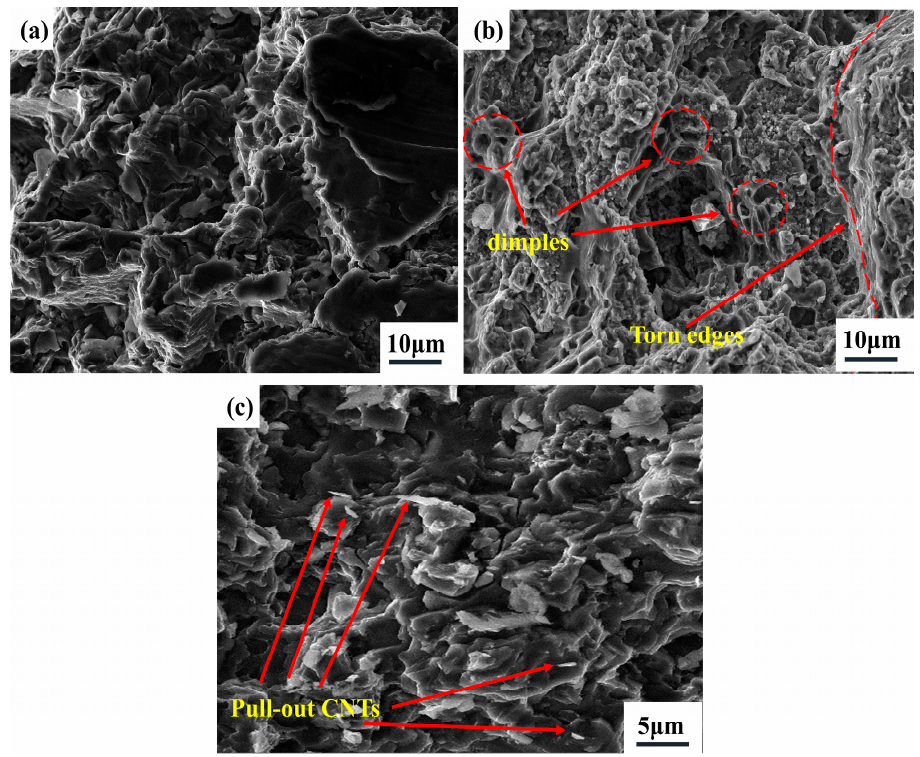
Figure 11. Fracture morphology of the two materials: ( a ) AZ91 matrix alloy; ( b ) and ( c ) 1.0 wt.% Ni-CNTs/AZ91 magnesium matrix composites.